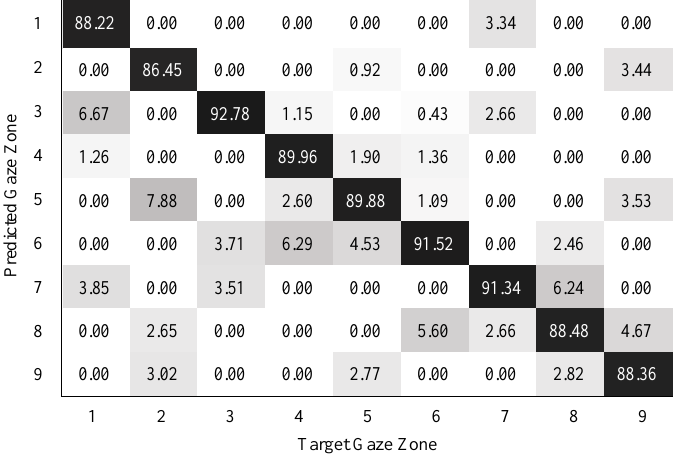
Figure 15. Gaze zone classification results based on the PointNetLK method and NN classifier.